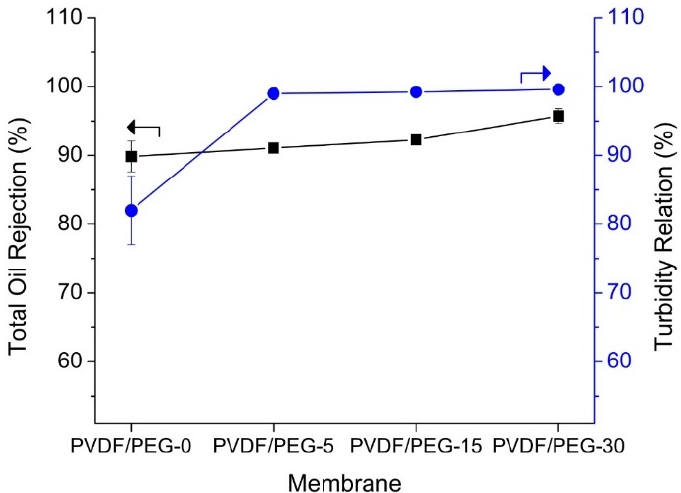
Figure 10. Figure 10. The quality of permeate in terms of oil rejection and turbidity obtained after 1.5 h of PW filtration.